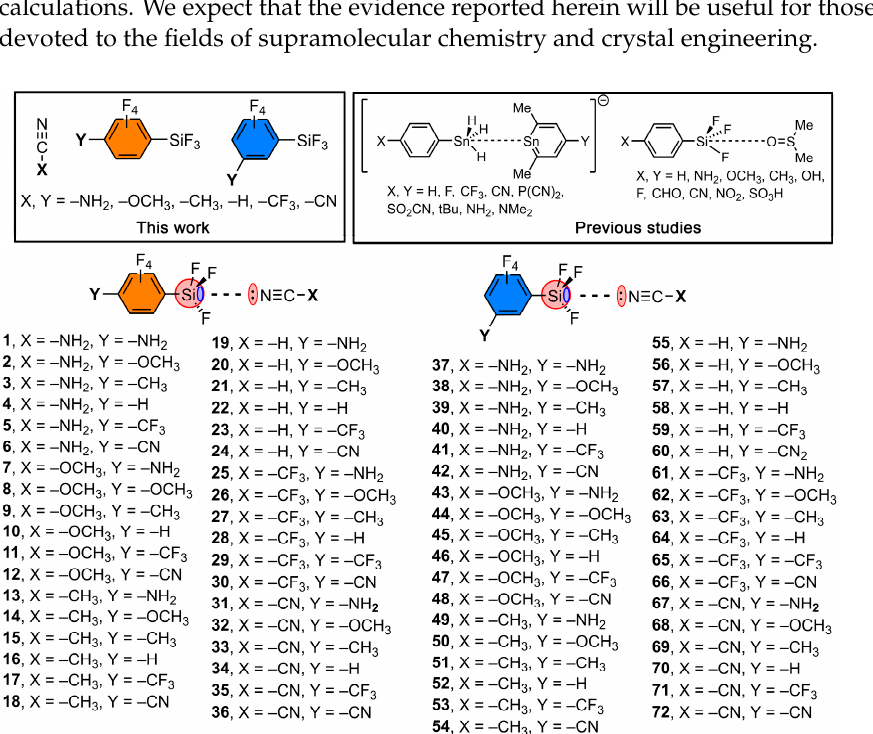
Figure 1. Compounds and complexes 1 to 72 studied in this